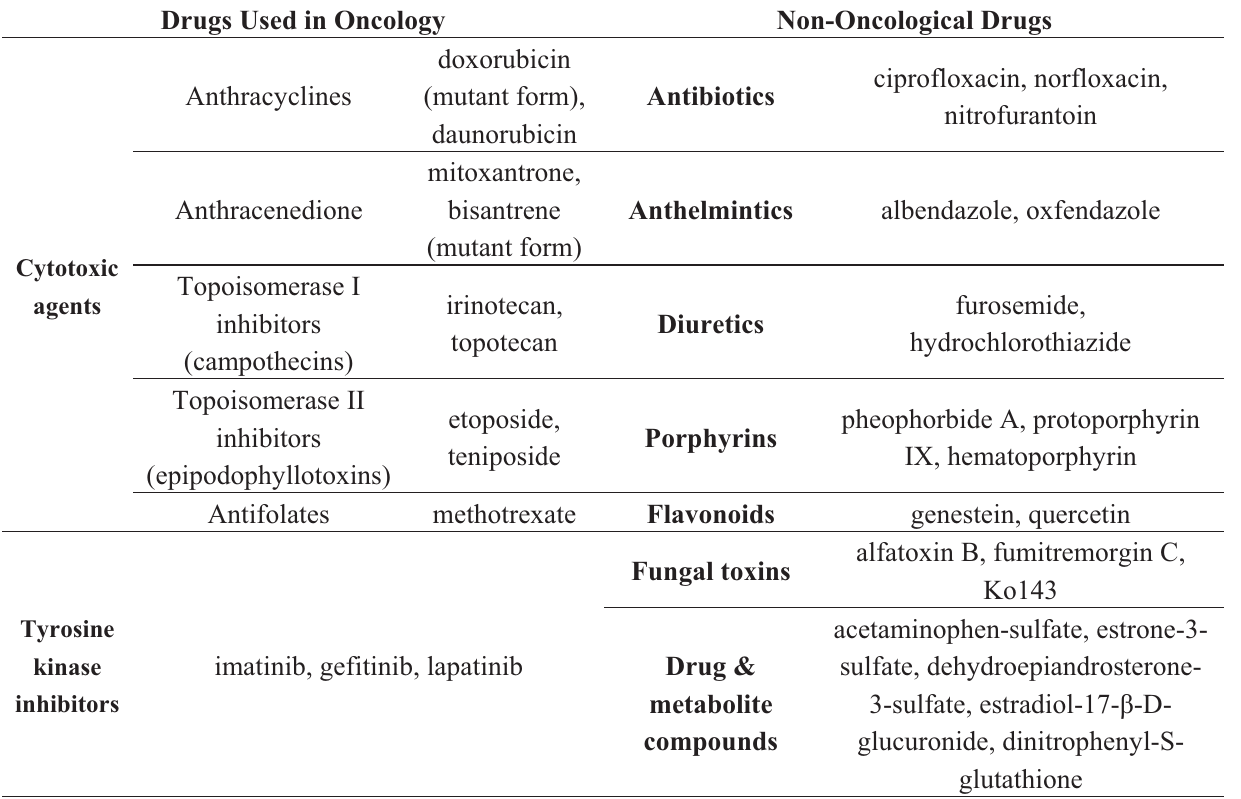
Table 7. A selection of clinically relevant drugs and compounds that are known Breast Cancer Resistance Protein (BCRP)-substrates